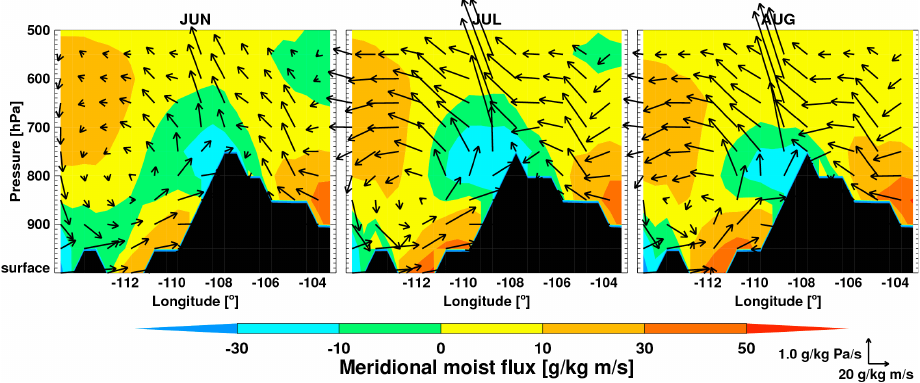
Fig. 8. Monthly mean cross sections of zonal circulation and meridional moisture fluxes at 29 ◦ N from 115 ◦ W to 105 ◦ W (Fig. 7) during the NAM season. The color contour shows the meridional moisture fluxes. The positive values represent southerlies and negative values represent northerlies.